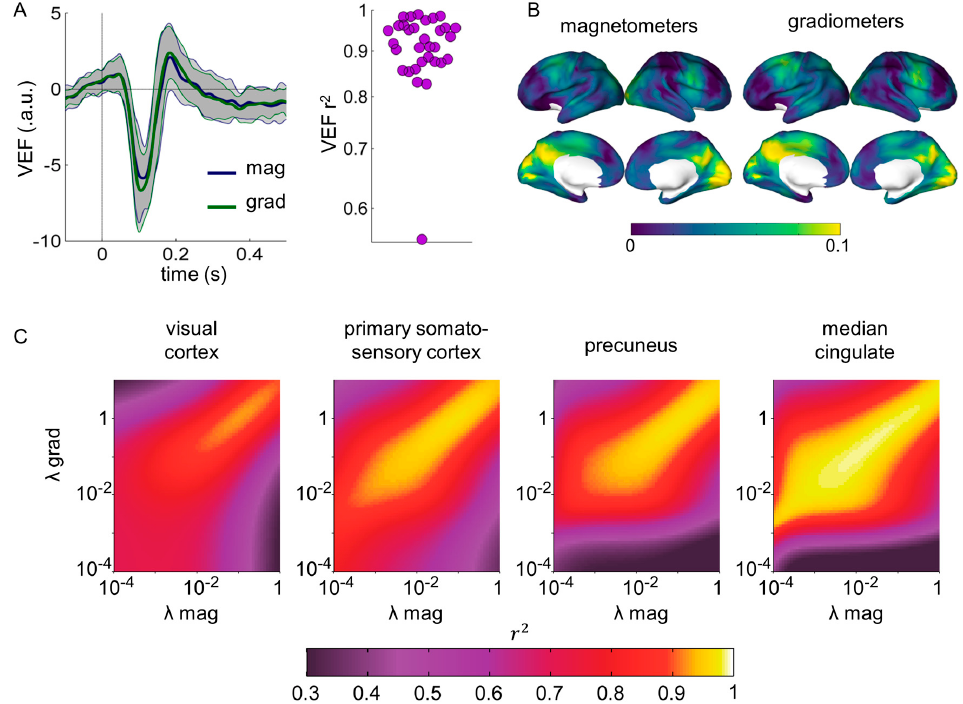
Figure 5. Similarity of the evoked and ongoing activity during a passive visual task estimated with magnetometers and gradiometers after SSS. ( A ) Sensor space Visual Evoked Fields (VEF). The gray areas represent the standard deviation across subjects. The squared Pearson correlation coefficients (r 2 ) between the magnetometer and gradiometer-derived VEFs are displayed for each subject. ( B ) Source activation at 60–160 ms after stimulus presentation compared to baseline ( − 100–0 ms). ( C ) Correlation between source time series derived from magnetometers and gradiometers. Beamforming filters and source power values were estimated from the average covariance matrix across all trials (from − 0.1 to 0.9 s relative to stimulus